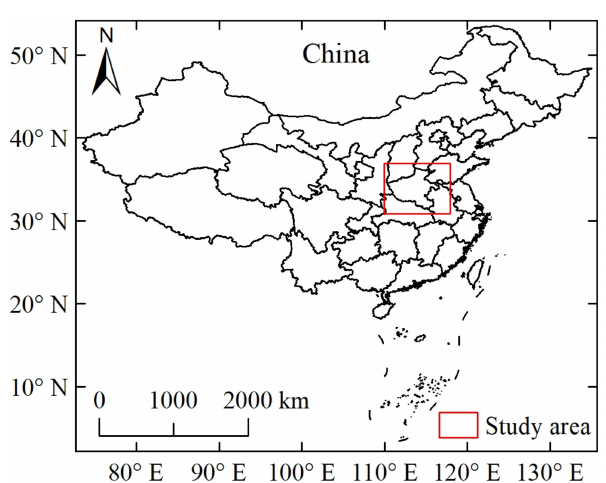
Figure 1. Borders of China with the study